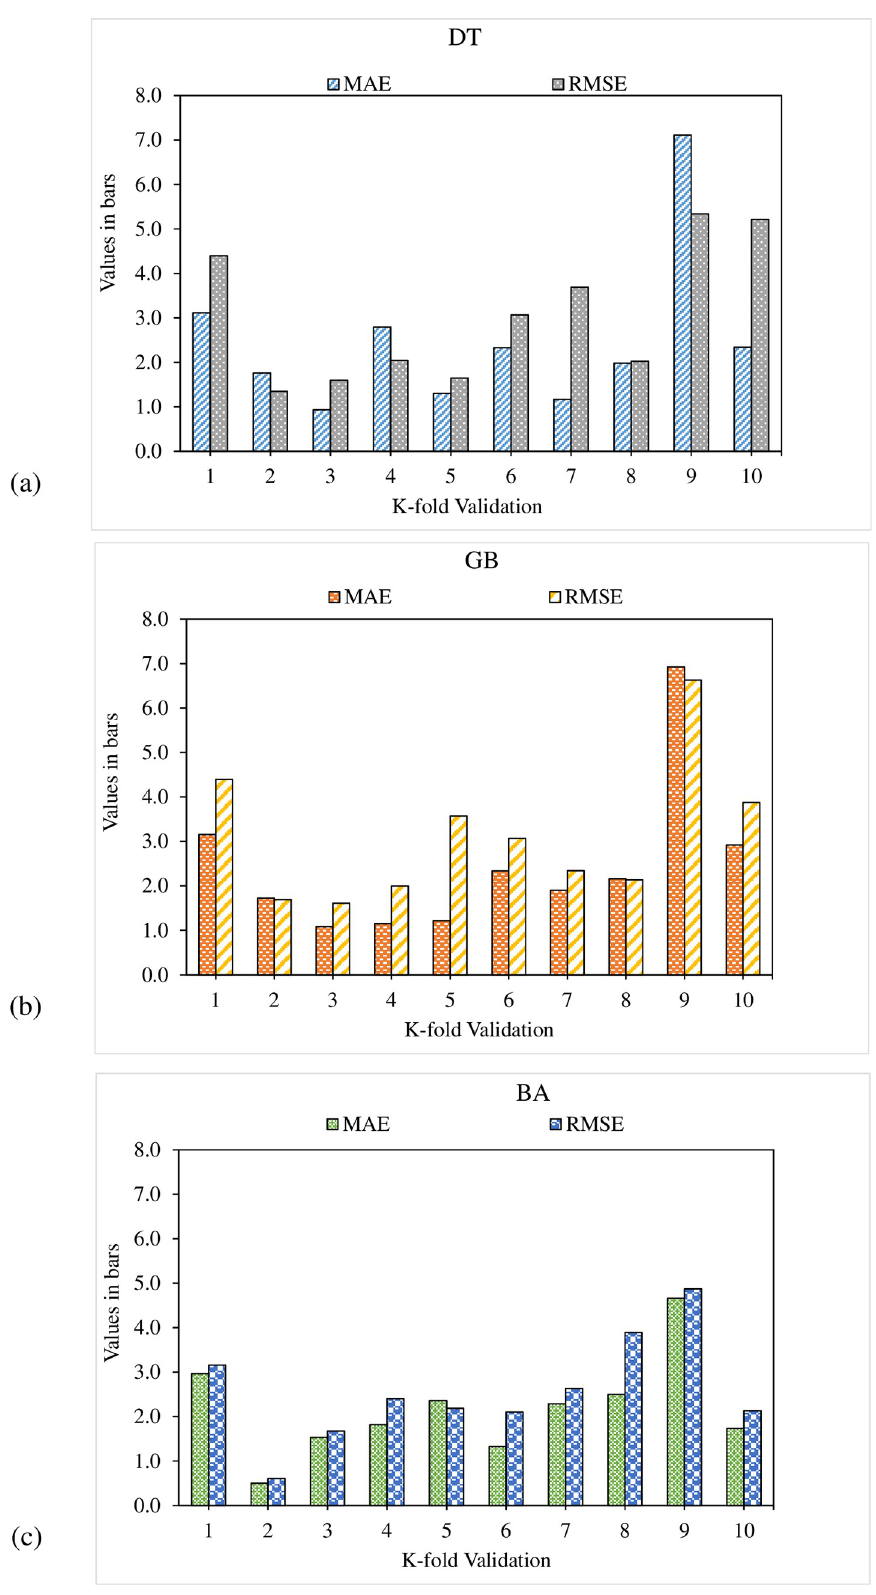
Fig 16. Flowability statistical representation: (a) DT; (b) GB; (c) BA.